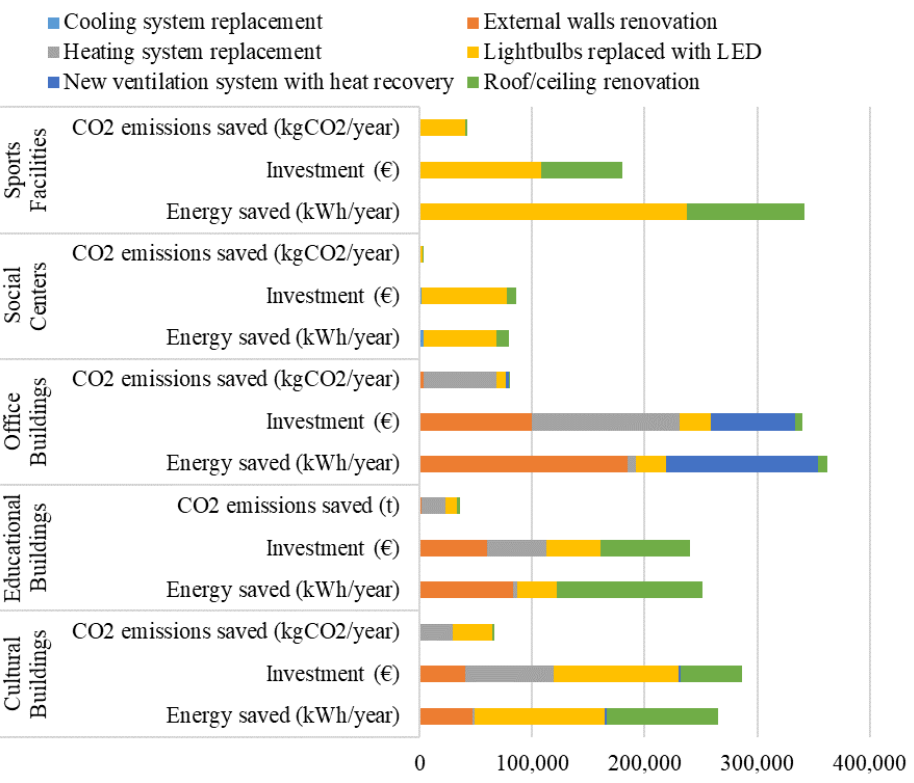
Figure 8. Summary of potential energy savings, investment and CO 2 emission savings of the selected actions to improve EE and renewable energies in the buildings, classified per building typology.